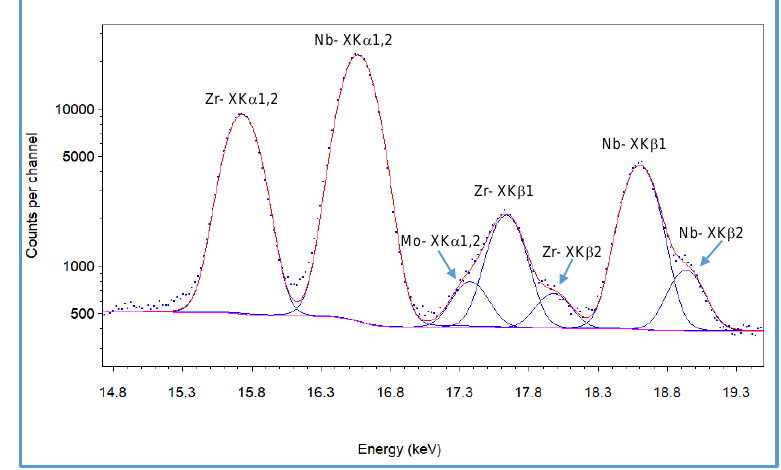
Fig. 3. Processing of the X-ray energy region of interest using COLEGRAM